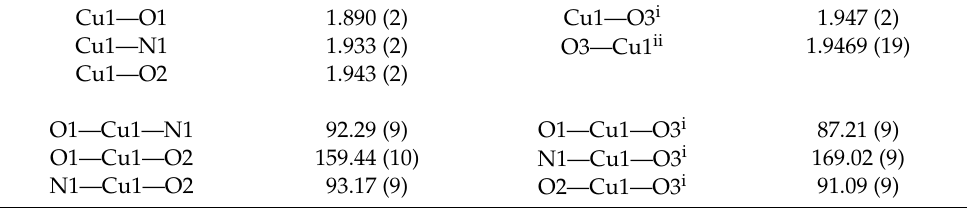
Table 2. Selected geometric parameters (Å, º) for 1